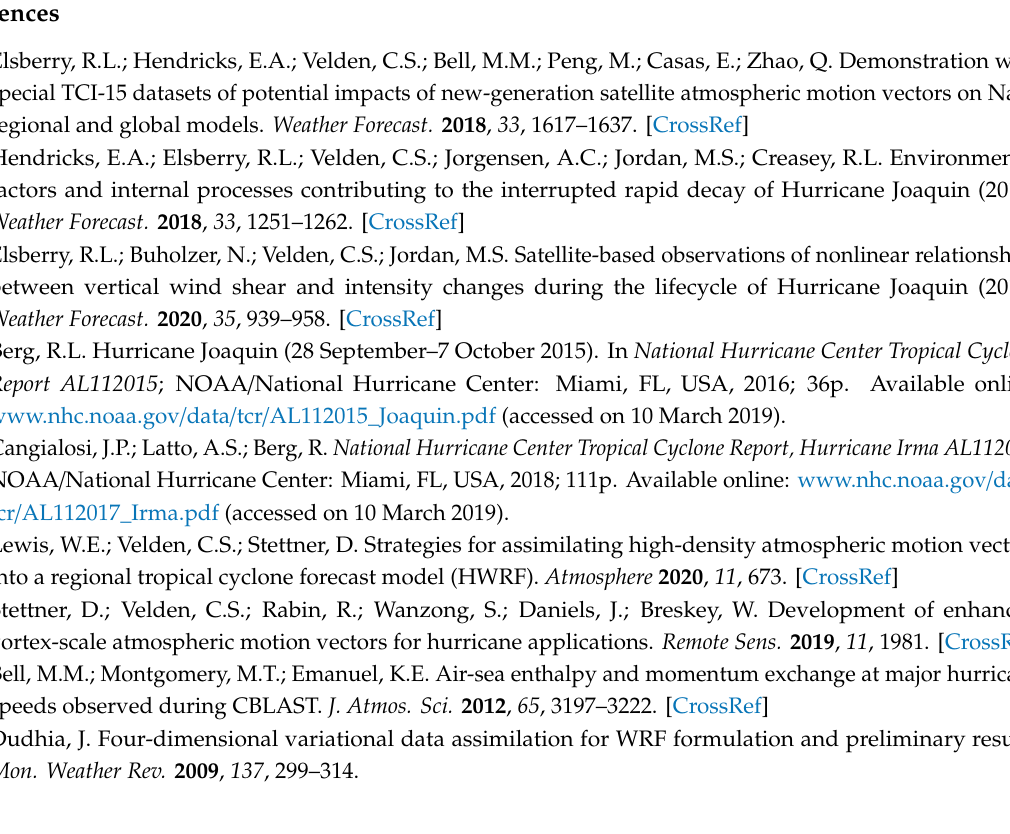
Figure A1. Wind increment vectors (m s − 1 , color scale along bottom) for nudging a 60 m s − 1 vortex with a RMW = 25 km to the north and to the east by one grid point. The red line representing the target path connects the starting position A with the ending position B.